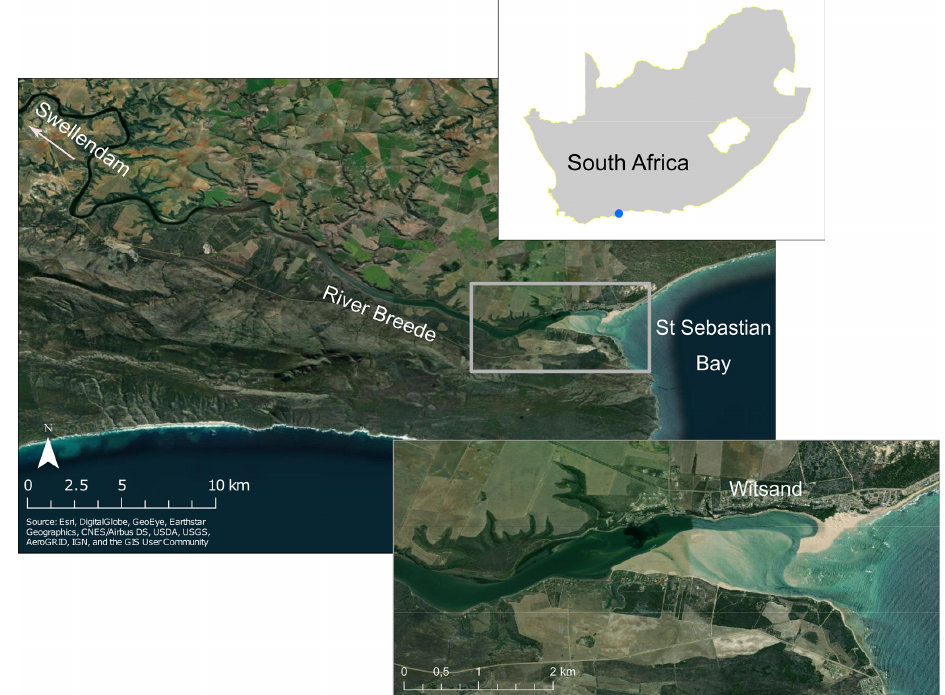
Figure 1. Location of the study area and aerial photographs showing the Breede River and the Breede